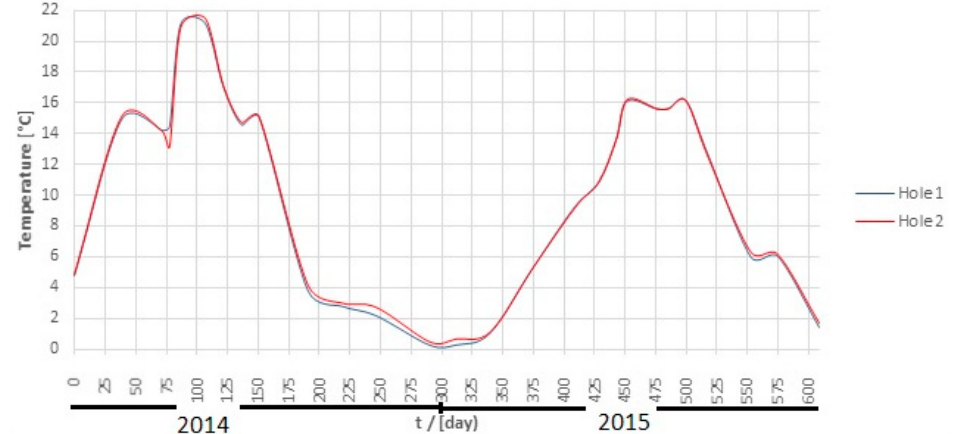
Figure 4. The temperatures in the soil at a 0.5 m depth under the lawn cover. Table 2. The timetable for the measurements, between April 2014 and March 2017; the number of days between two measurements ( ∆ t ), and the time t [day] since the beginning of the measurements (used as the x -axis in Figures 3–6).